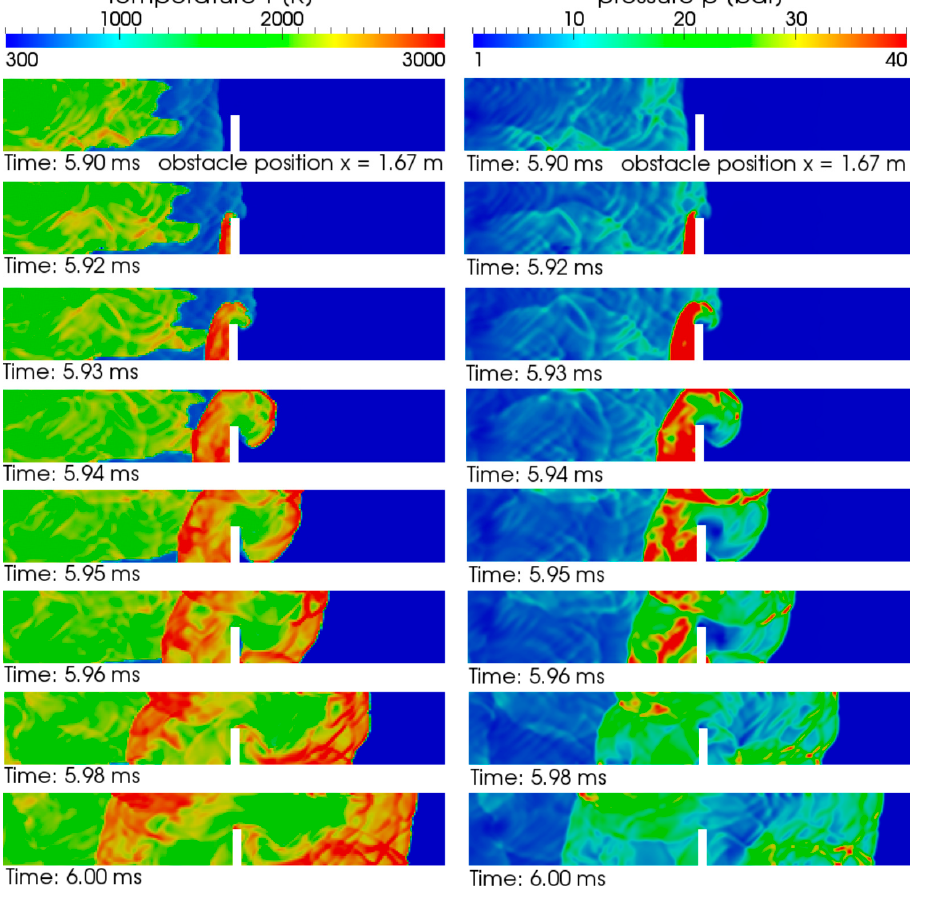
Figure 5. Transition to detonation due to the shock wave reflection at the obstacle for case 50% H 2 and S = 3H. and S =